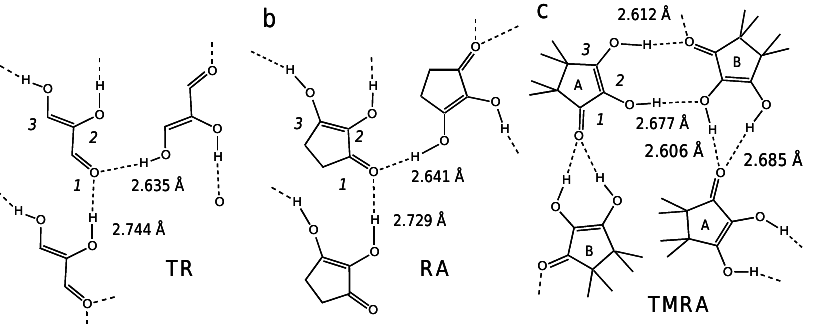
Figure 4. Hydrogen bond patterns (schematically) resulting from the crystallographic structures of ( a ) triose reductone TR [31], ( b ) reductic acid RA [32] and ( c ) TMRA [33]. The O . . . O distances of the OHO hydrogen bonds are included.